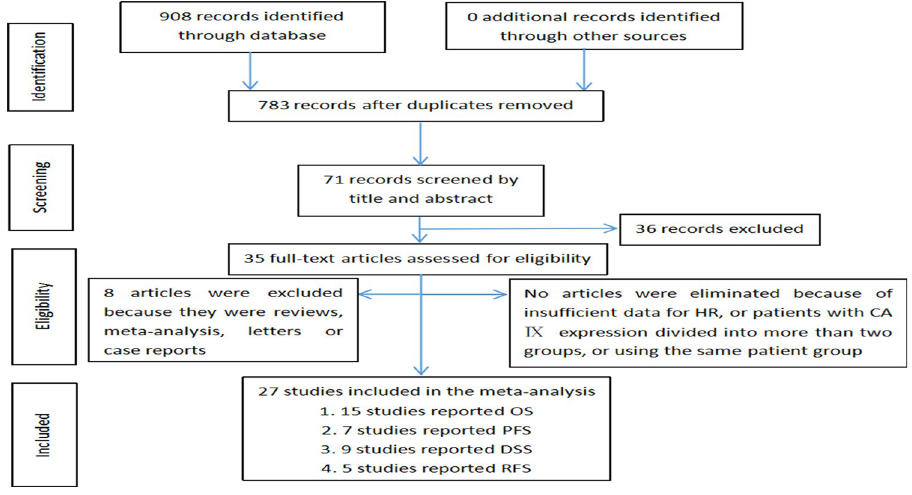
Fig 1. Flow chart of study